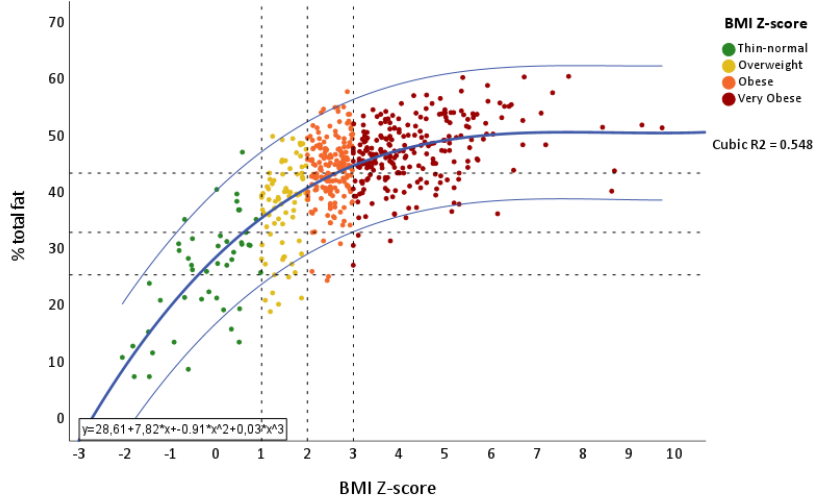
Figure 2. Curvilinear adjustment of BMI Z-score over total fat percentage, showing the cut-off points according to both cut-off points.